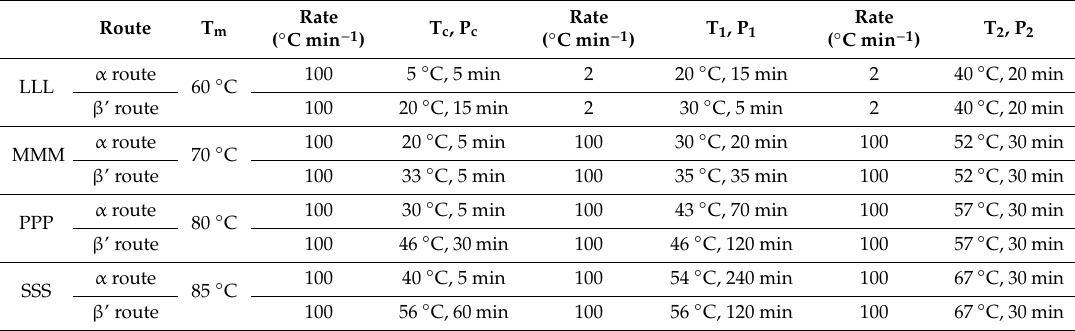
Table 3. Heat treatment conditions for producing multiple β forms of